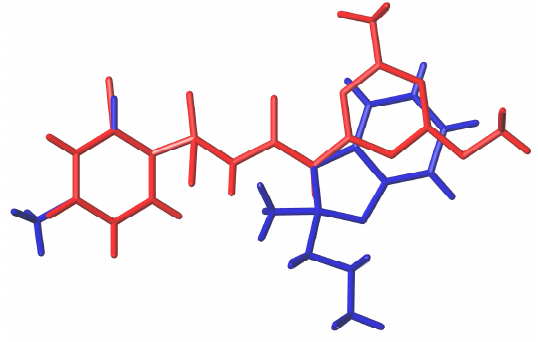
Figure 1. Superimposed molecular structure modeling. The structure of chlorsulfuron is shown in red, and compound 3c is shown in blue.